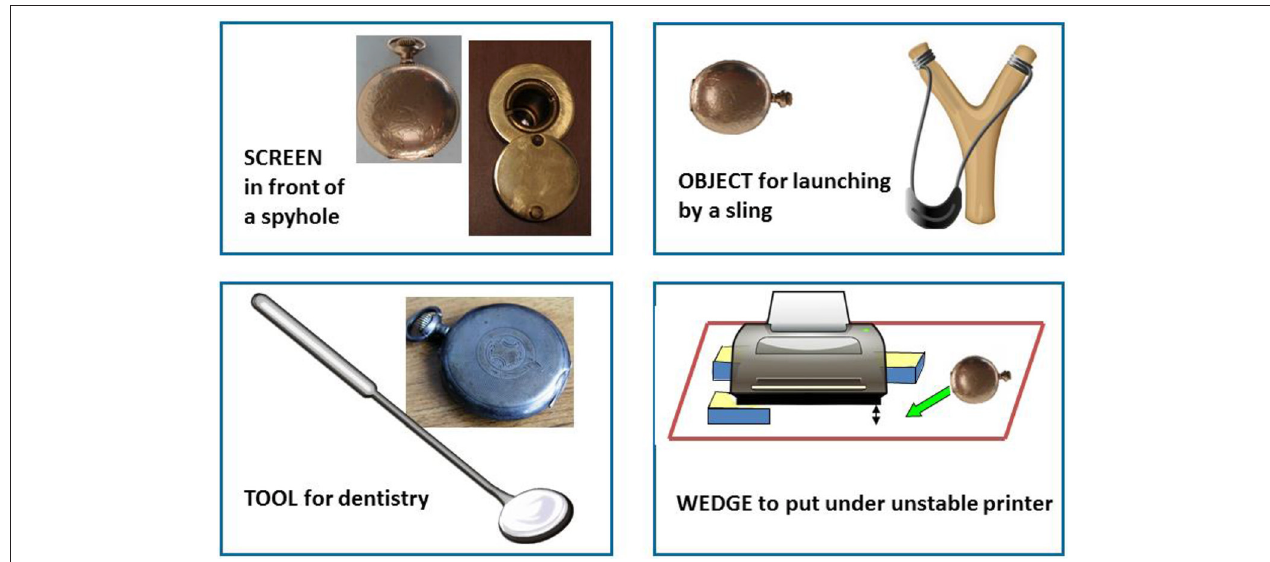
FIGURE 3 | The emergence of new holons as a fortuitous combination of an existing realization of structural type playing a new role needed by the complex adaptive system.